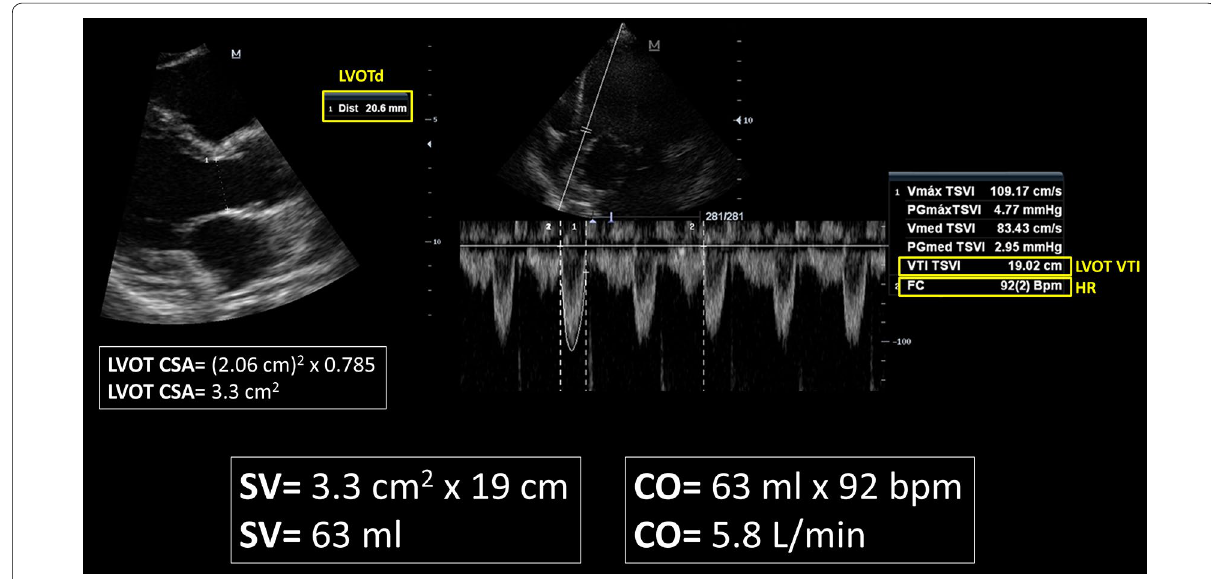
Fig. 2 Calculation of the stroke volume (SV) and cardiac output (CO) by transthoracic echocardiography in a critically ill patient without hemodynamic compromise. LVOT: left ventricular outflow tract; d: diameter; CSA: cross-sectional area; VTI: velocity–time integral; HR: heart